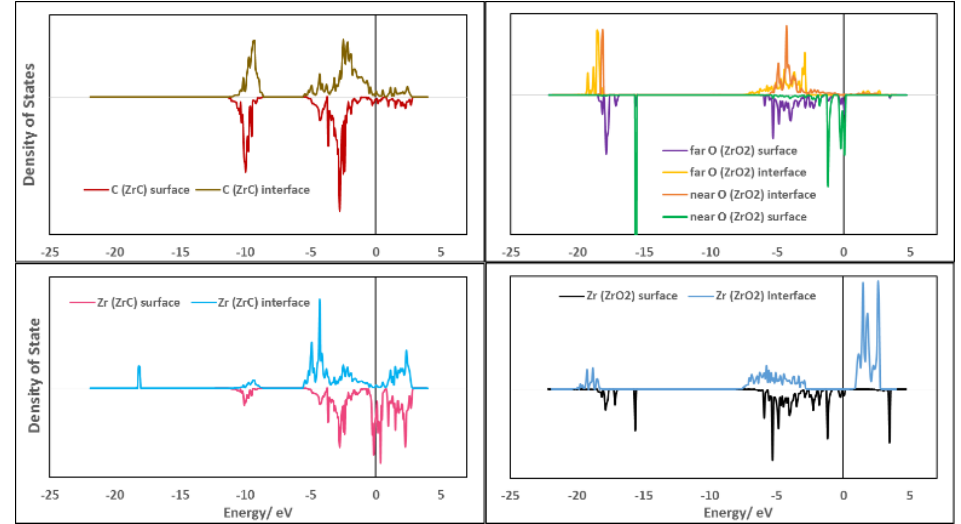
Figure 9. Comparison of the PDOS of each atom at the interface and the corresponding surface slab for the Zr|OO|Zr|OO—ZrC(111) top site interface model. The upper part of the spectra of each plot are for atoms in the interface structure and those at the lower part are for the atoms in the corresponding surface slabs. Atoms labeled as near are closer to the interface plane than atoms labeled as